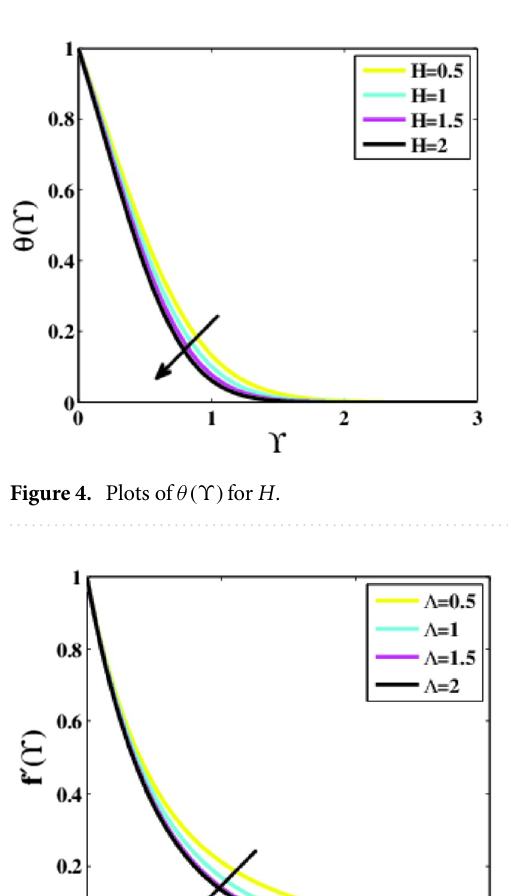
Figure 3. Plots of f